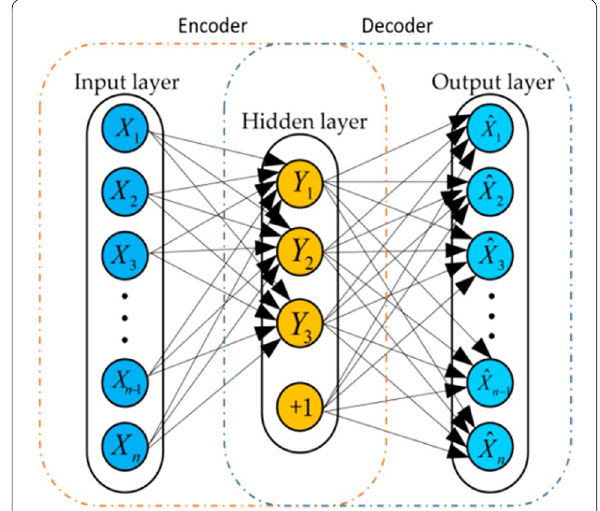
Figure 3 Single autoencoder (AE) architecture